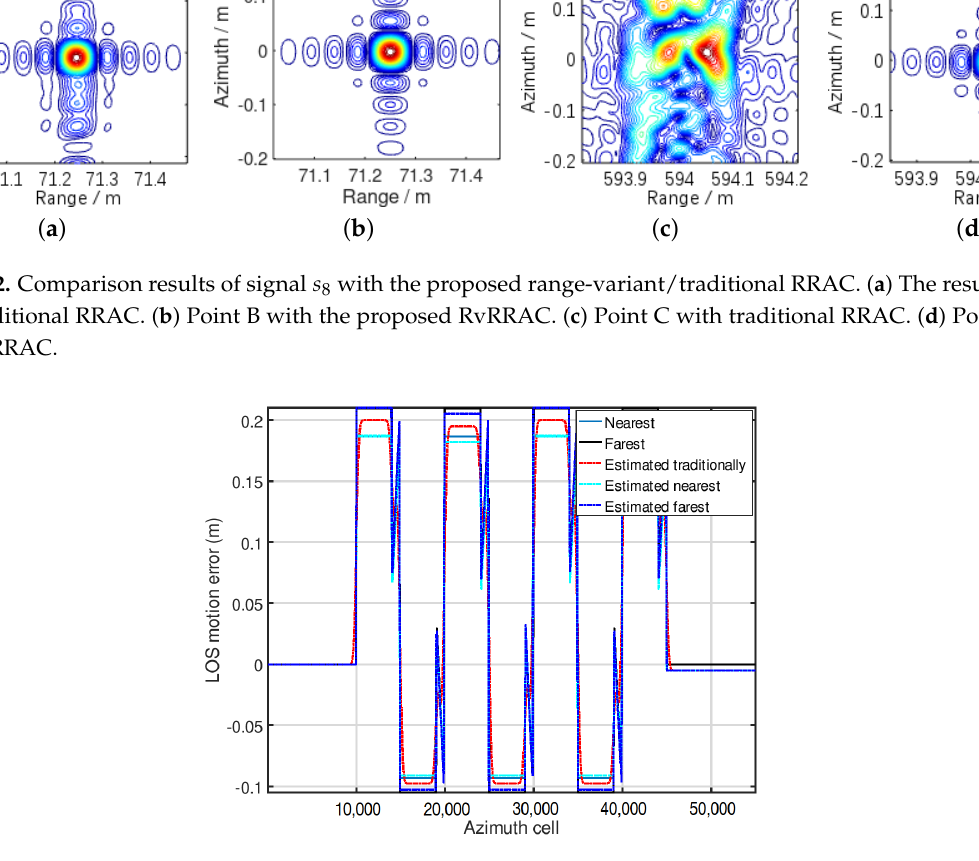
Figure 13. Comparison of added motion error and estimated motion error of Point A in signal s 8 . Table 5. Point Target Analysis of Residual LOS Motion Error Auto-Correction with Signal s 8